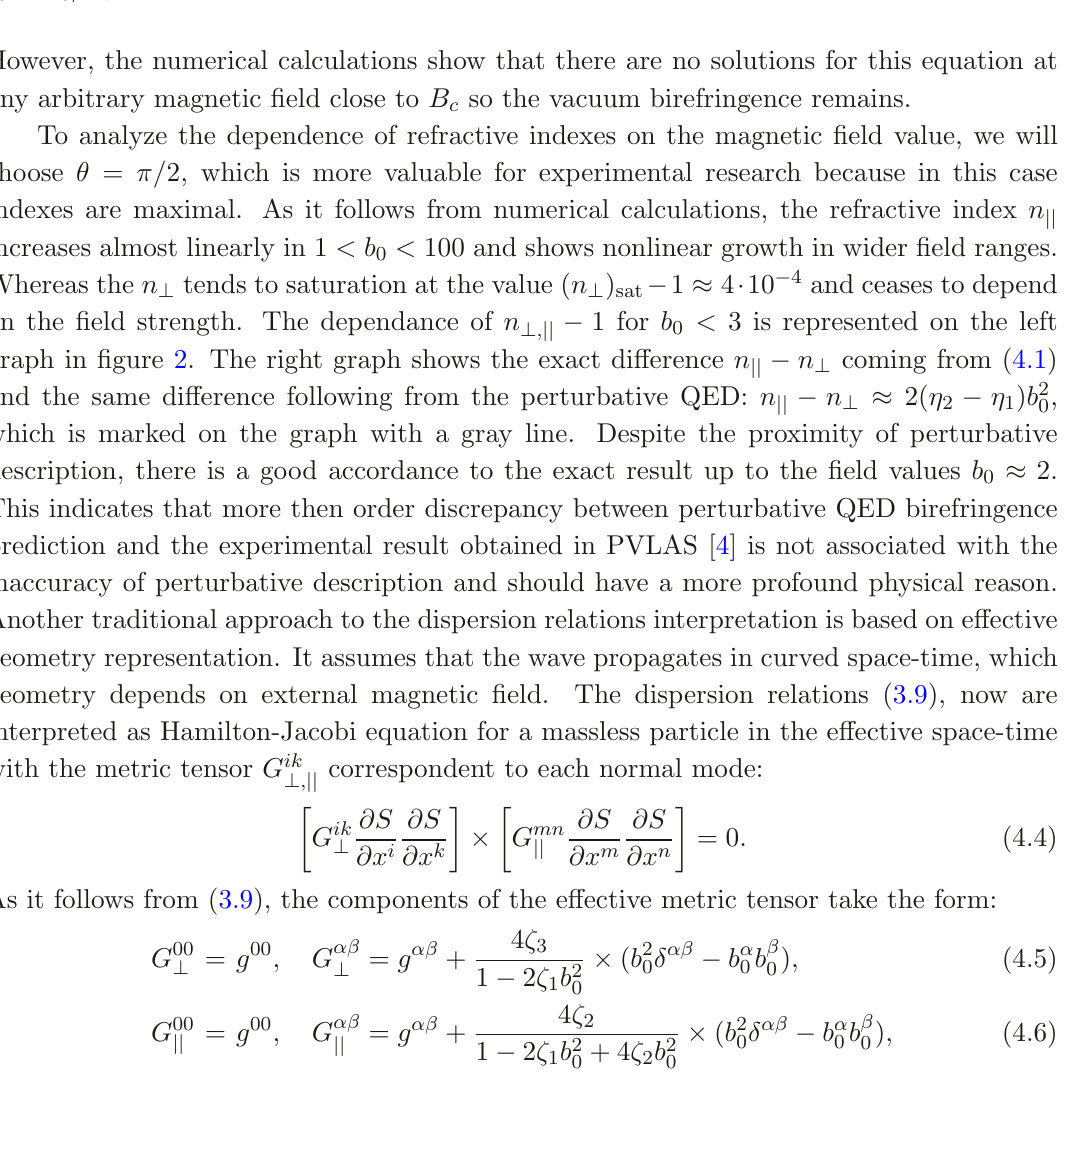
Figure 2 . The refractive indexes and their difference depending on the magnetic field value b 0 = B 0 /B c